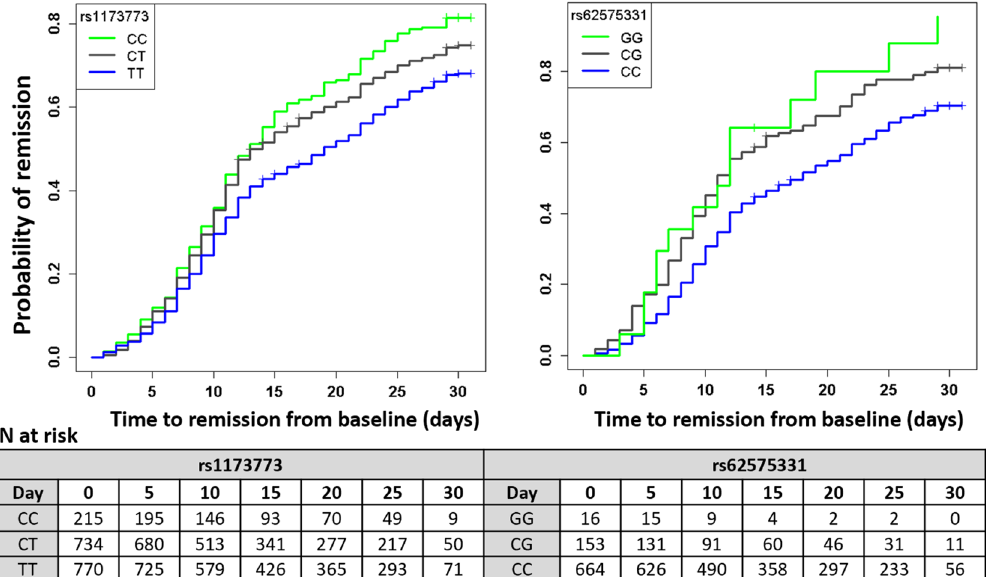
Figure 2. Cumulative incidence curves for COVID-19 symptom